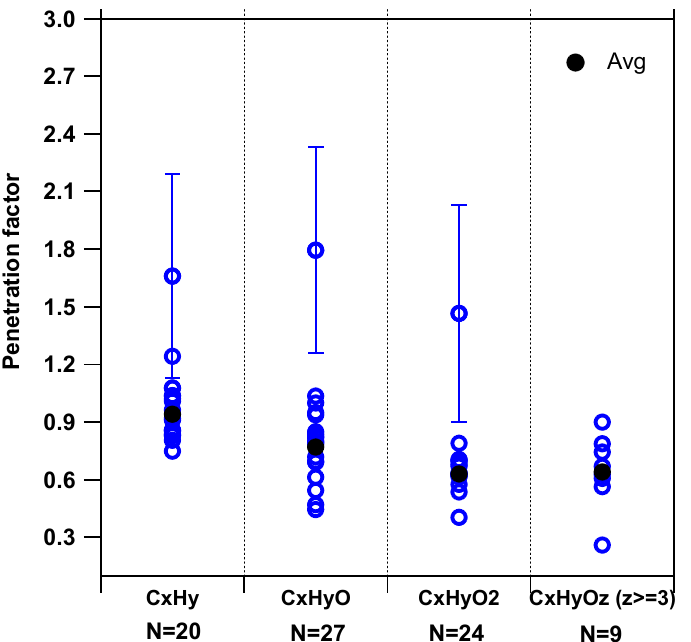
Figure 5. Penetration factors derived for different categories of VOCs. Average values are shown in black. Error bars represent 3 σ . N is the number of species reported for each category.